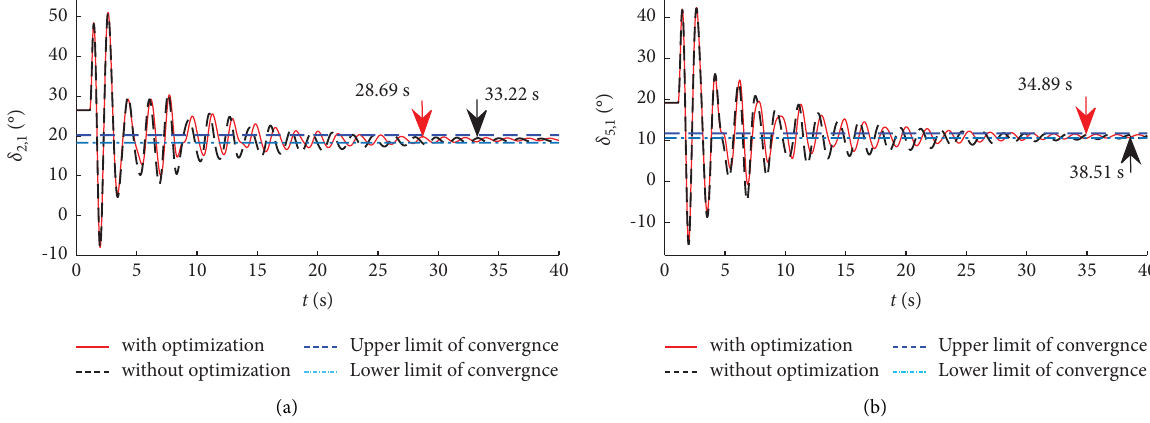
Figure 8: Power angle diference between SGs with and without optimization to I (b) Power angle diference between #5 and #1 SGs.